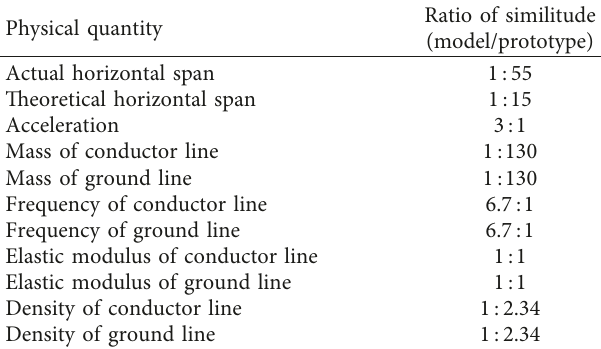
Table 2: Similitude coefficients of the model conductor line and ground